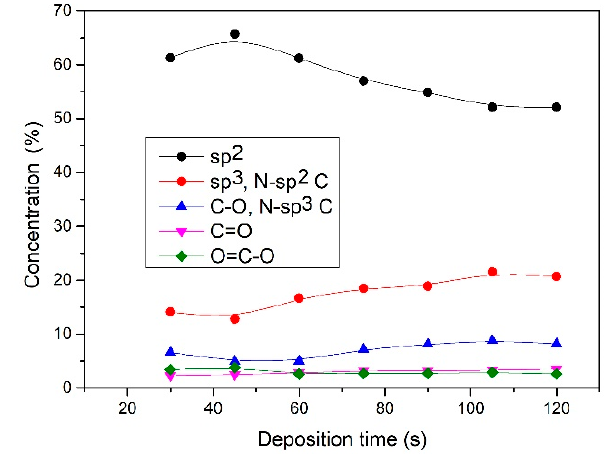
Figure 10. Evolution of chemical structure with deposition time.